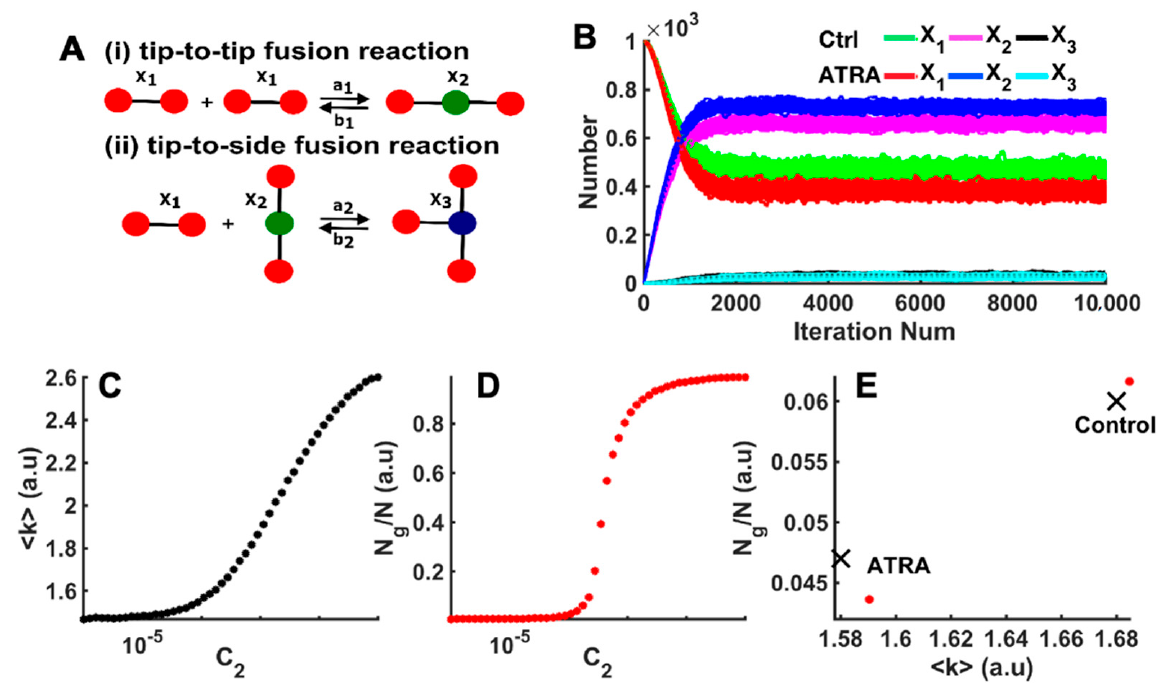
Figure 6. Estimating relative fusion and fission rates using agent-based model. ( A ) Model scheme representing the tip-to-tip fusion of two X 1 nodes into X 2 . Tip-to-side fusion of one X 1 node with one X 2 node to form one X 3 node, as well as the corresponding fission processes. ( B ) The number of vehicle (control), or ATRA X 1 , X 2 , and X 3 species from the model as functions of the number of iterations using the C 1 and C 2 values given in Table 1. Model results for mean degree ( C ) and N g /N ( D ) as functions of C 2 at fixed C 1 = 0.0007 and n = 3000. ( E ) Comparison of N g /N versus <k> values obtained from experiment (red bullets) and simulation (black crosses) in control and ATRA-treated cells. Table 1. Comparison of microscopic parameters of mitochondrial network obtained from experi- ments (Exp) and simulations (Theory). Mean degree (columns 2 and 3) and Ng/N (columns 4 and 5) from experiment and theory. Columns 6 and 7 list the values of C1 (tip-to-tip fusion/fission ra- tio) and C2 (tip-to-side fusion/fission ratio) obtained by fitting the model to the data. Notice that C1 decreased by 83% in ATRA-treated cells compared to control.